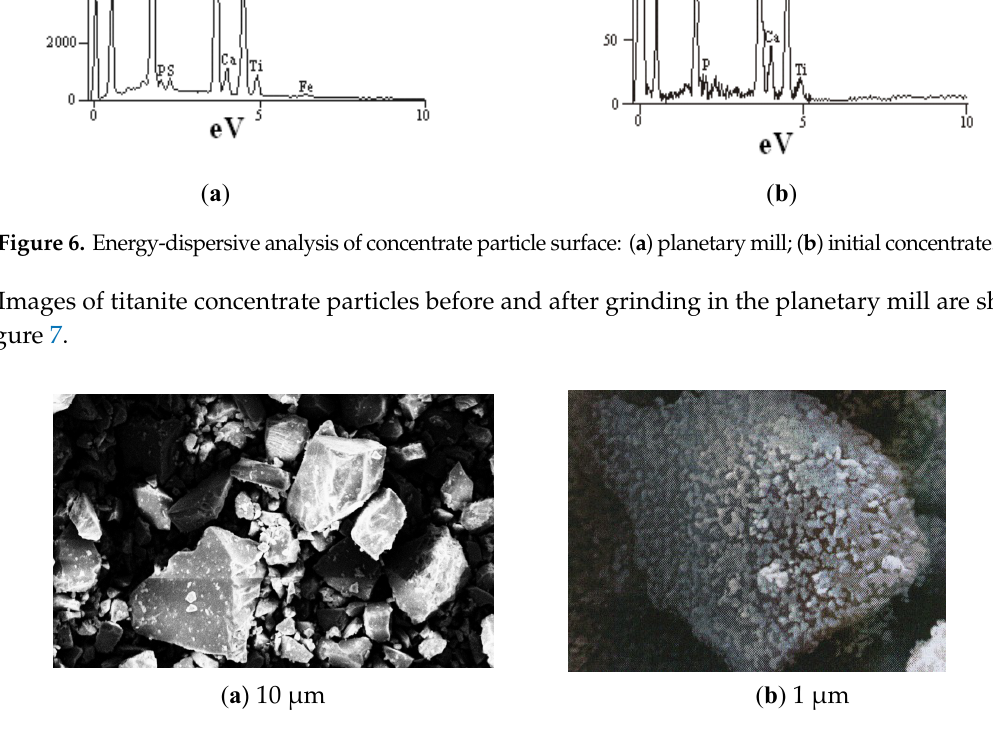
Figure 7. SEM images of titanite particles: ( a ) – before grinding; ( b ) — after grinding